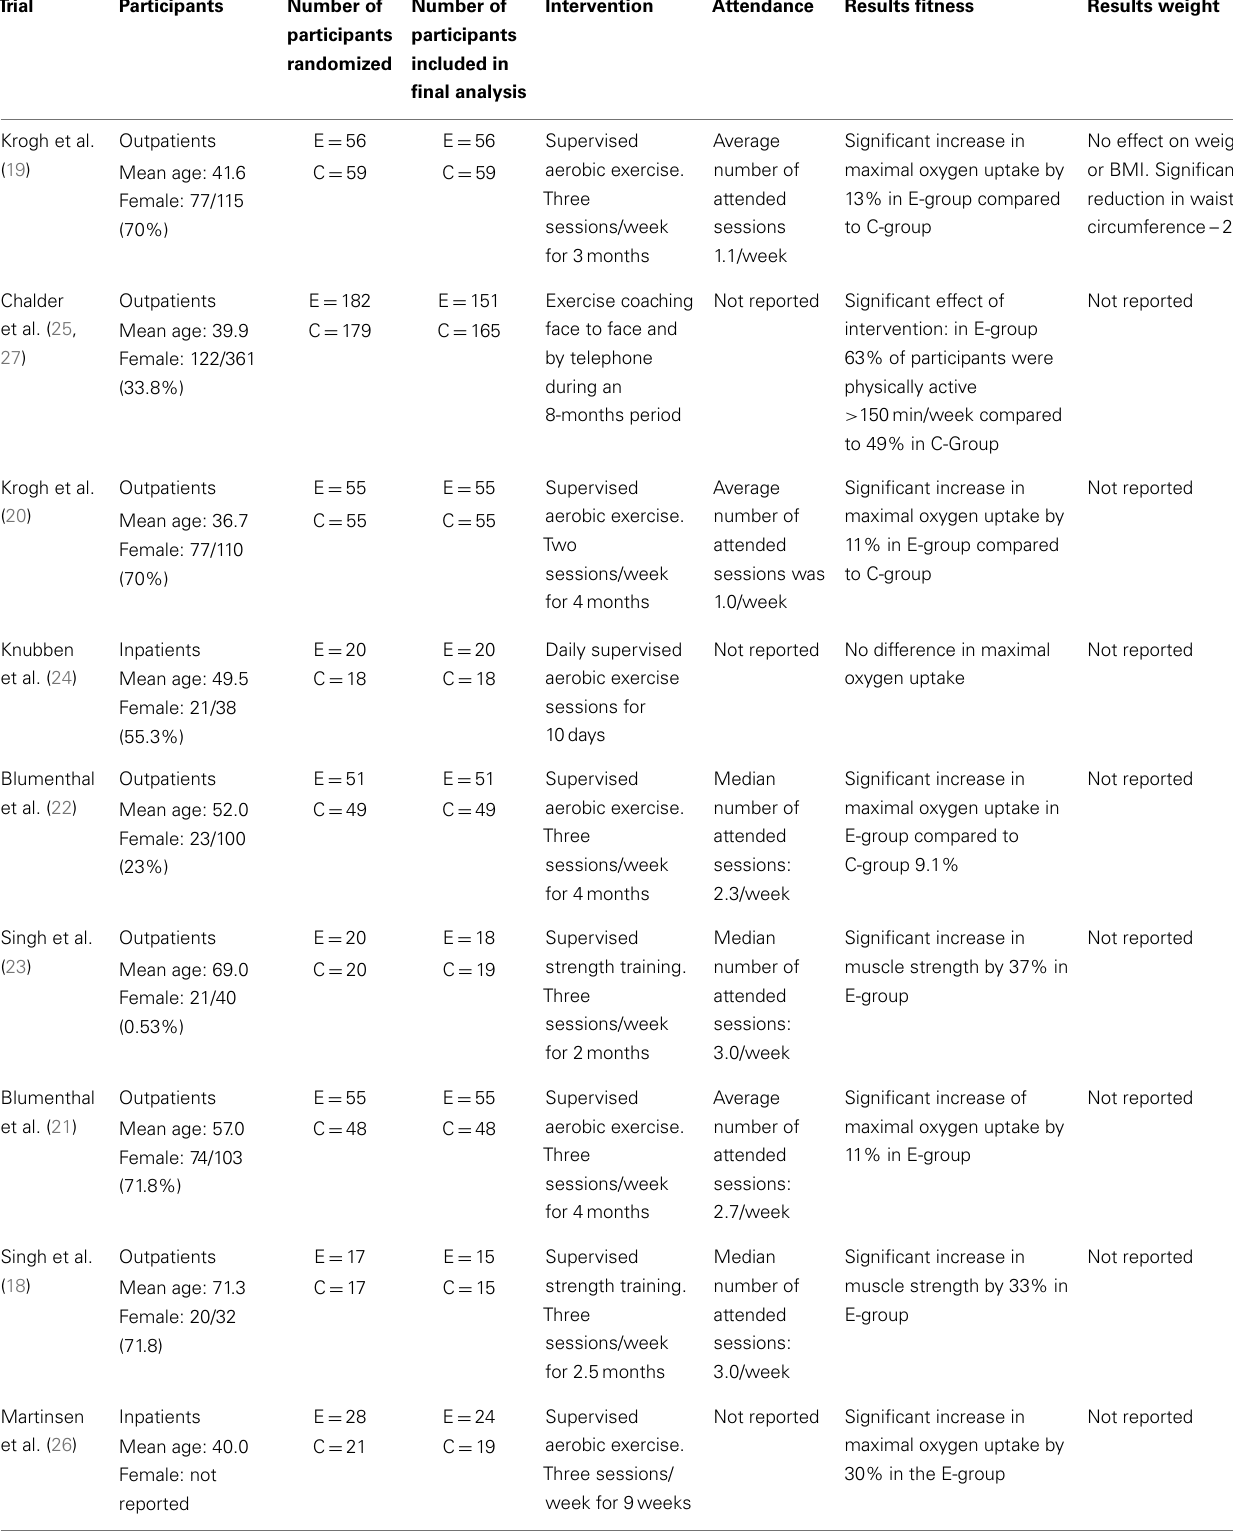
Table 2 | Randomized clinical trials reporting effect of exercise interventions on physical fitness or strength in patients with depression .